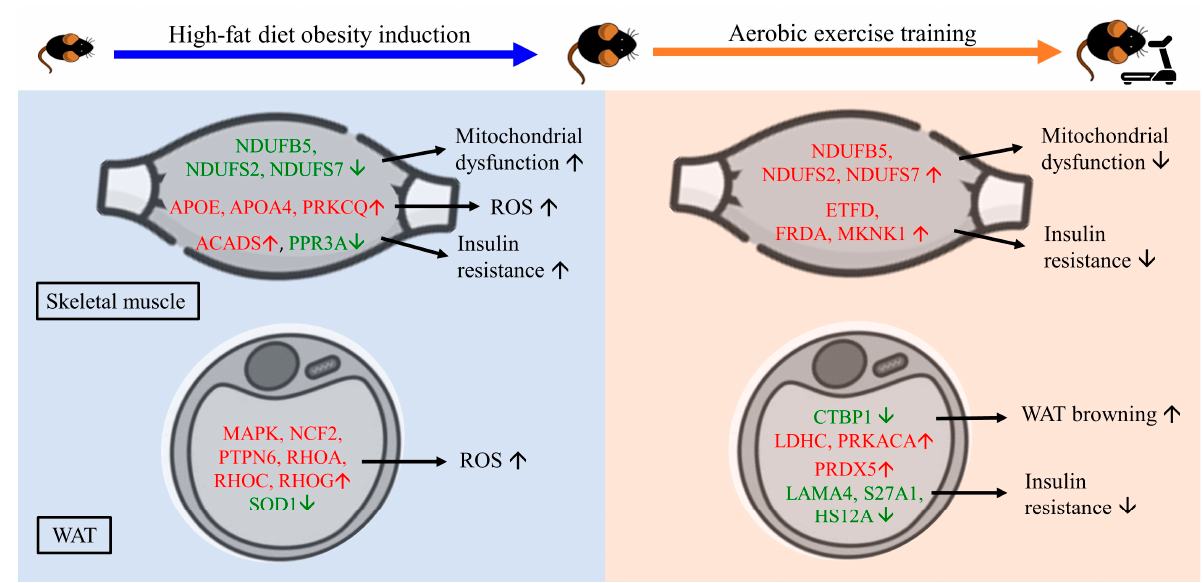
Figure 7. Graphical summary (WAT—white adipose tissue, ROS—reactive oxygen species) (The proteins with red letters were upregulated, whereas those with green letters were downregulated) (The black arrows pointing up and down represent predicted increases or decreases in biofunction, respectively.).